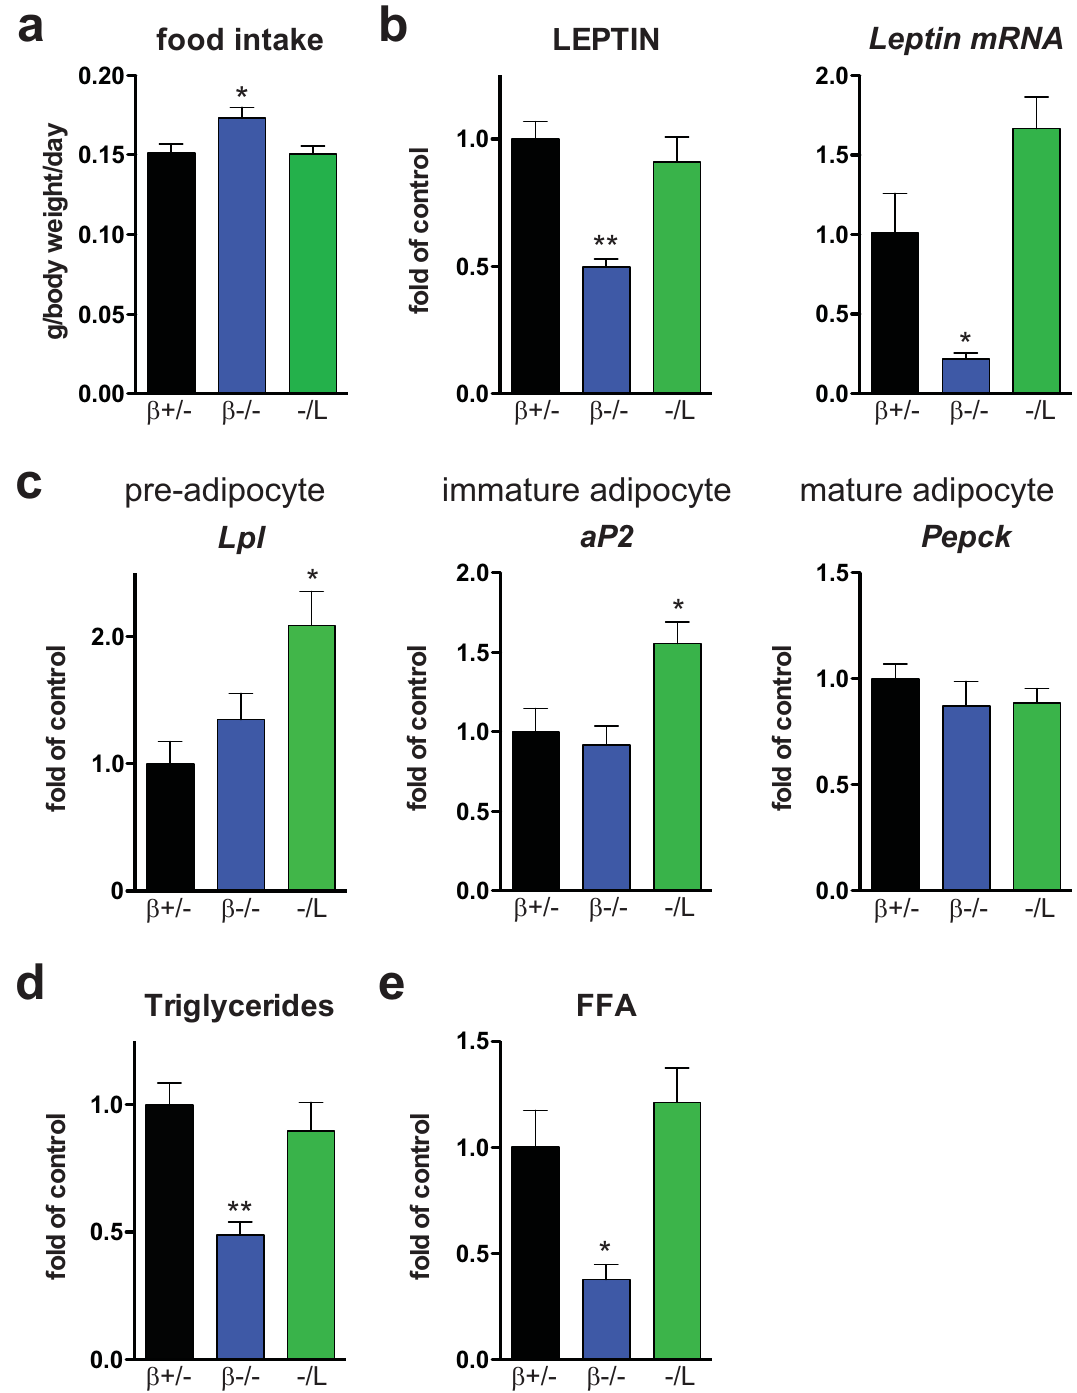
Figure 2. Adipocyte differentiation and lipid homeostasis in Cebpb mutant mice. ( a ) Food intake per mouse, normalized to body weight as determined over 4 consecutive days. ( b ) Plasma level of leptin and real-time PCR analysis of leptin in gonadal fat pad. ( c ) Real-time PCR analysis of the adipocyte differentiation markers Lpl (pre-adipocytes), aP2 (immature adipocytes), and Pepck (mature adipocytes). ( d ) Plasma levels of triglycerides and free fatty acids (FFA). In all panels, data are presented as mean ± SEM. * P < 0.05, ** P < 0.01 by Student’s t - test. Mice were 5-month-old ( b – d ) or 8-week-old ( a ), n = 4–7 per